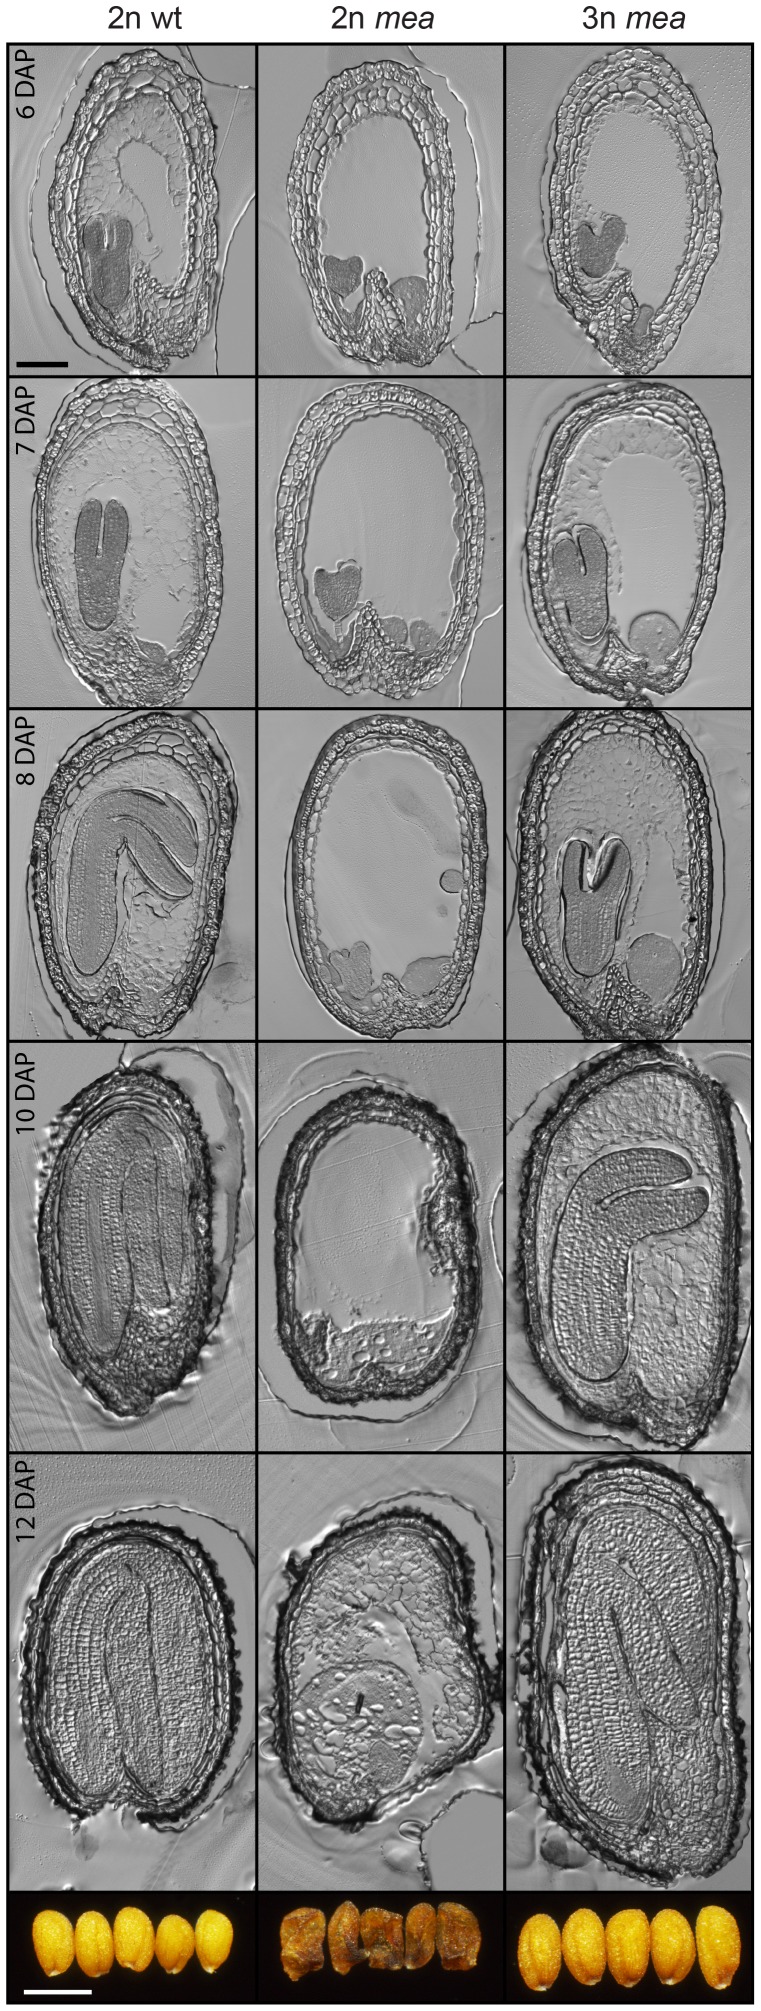
Endosperm Cellularization Is Restored in Triploid mea Seeds.Sections of seeds from 2n×2n (left panels), mea/MEA×2n (middle panels) and mea/MEA; osd1/osd1×2n (right panels) crosses at 6–12 days after pollination (DAP). Bar = 100 µm. Images of mature seeds are shown in bottom panels. Bar = 0.5 mm.